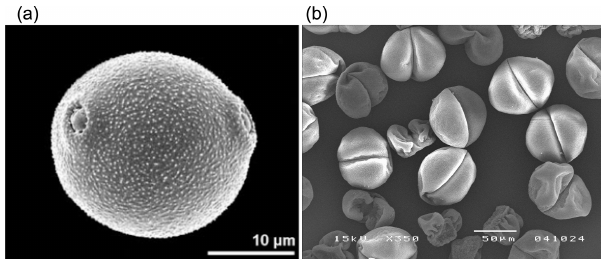
Figure 4. Pollen micrographs are shown. (a) Birch ( Betula pendula ) pollen grain (source: Halbritter and Diethart, 2016). (b) Spruce ( Picea abies ) pollen grains (source: the Biodiversity Unit of the University of Turku, Kari